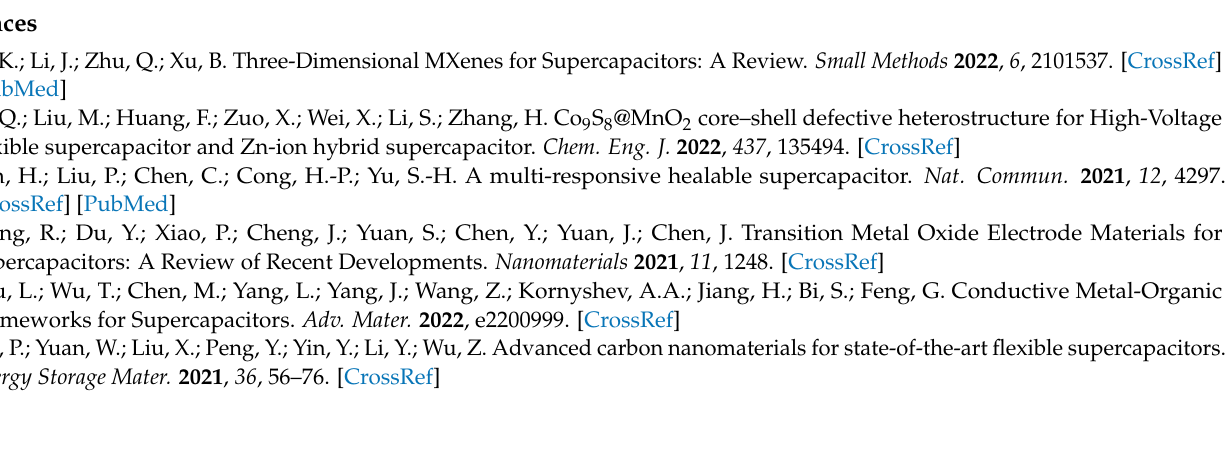
the screen-printed electrodes; Figure S2: Schematic illustration for the preparation of the Ni(OH)2 nanospheres; Figure S3: EDS spectrum of the Ni(OH)2 nanospheres; Figure S4: XRD patterns of Ni(OH)2-24, Ni(OH)2-36, Ni(OH)2-48 and Ni(OH)2-60; Figure S5: FT-IR spectra of Ni(OH)2-24, Ni(OH)2-36, Ni(OH)2-48 and Ni(OH)2-60; Figure S6: CV curves of Ni(OH)2-24, Ni(OH)2-48 and Ni(OH)2-60 electrodes.; Figure S7: GCD curves of Ni(OH)2-24, Ni(OH)2-48 and Ni(OH)2-60 elec- trodes; Figure S8: N2 adsorption/desorption isotherm plots and the corresponding pore size dis- tribution of Ni(OH)2-24, Ni(OH)2-36, Ni(OH)2-48 and Ni(OH)2-60; Figure S9: Nyquist plots of the Ni(OH)2-36//AC ASC before and after cycles (the inset show the enlarge high-frequency region of the plot and the equivalent circuit); Table S1: Specific capacitance comparison of Ni(OH)2-based materials from literature reports [22,50–58]; Table S2: Specific surface area, total pore volume and average pore size parameters for Ni(OH)2-24, Ni(OH)2-36, Ni(OH)2-48 and Ni(OH)2-60; Table S3: The EIS parameters of Rs, Rct, Wa and C for Ni(OH) 2 -24, Ni(OH) 2 -36, Ni(OH) 2 -48 and Ni(OH) 2 -60 electrodes; Table S4: The EIS parameters of Rs , Rct , Wa and C for the Ni(OH) 2 -36//AC ASC before and after